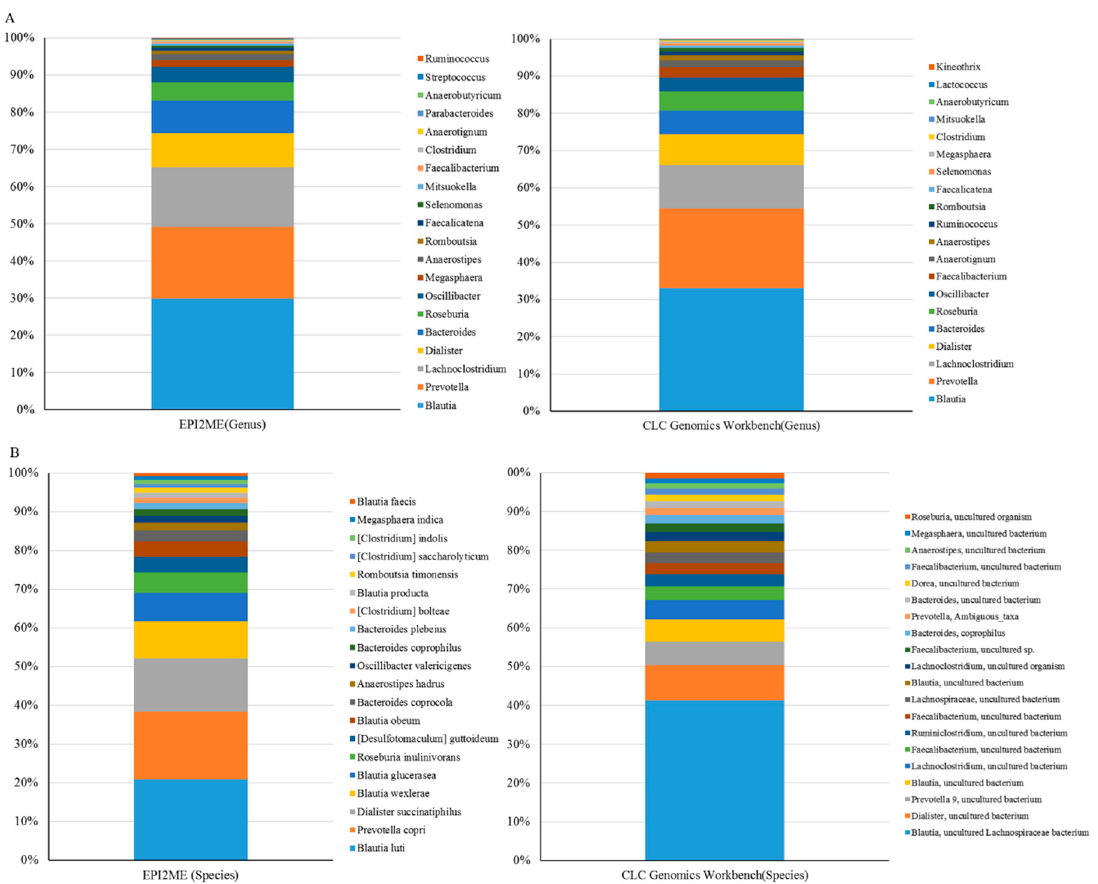
Figure 3. MinION results were subjected to taxonomic assignment using distinct bioinformatics workflows. Long-read amplicons were classified using the EPI2ME algorithm or Microbial module with the SILVA or NCBI 16S databases: at the genus level ( A ); or at the species level ( B ).